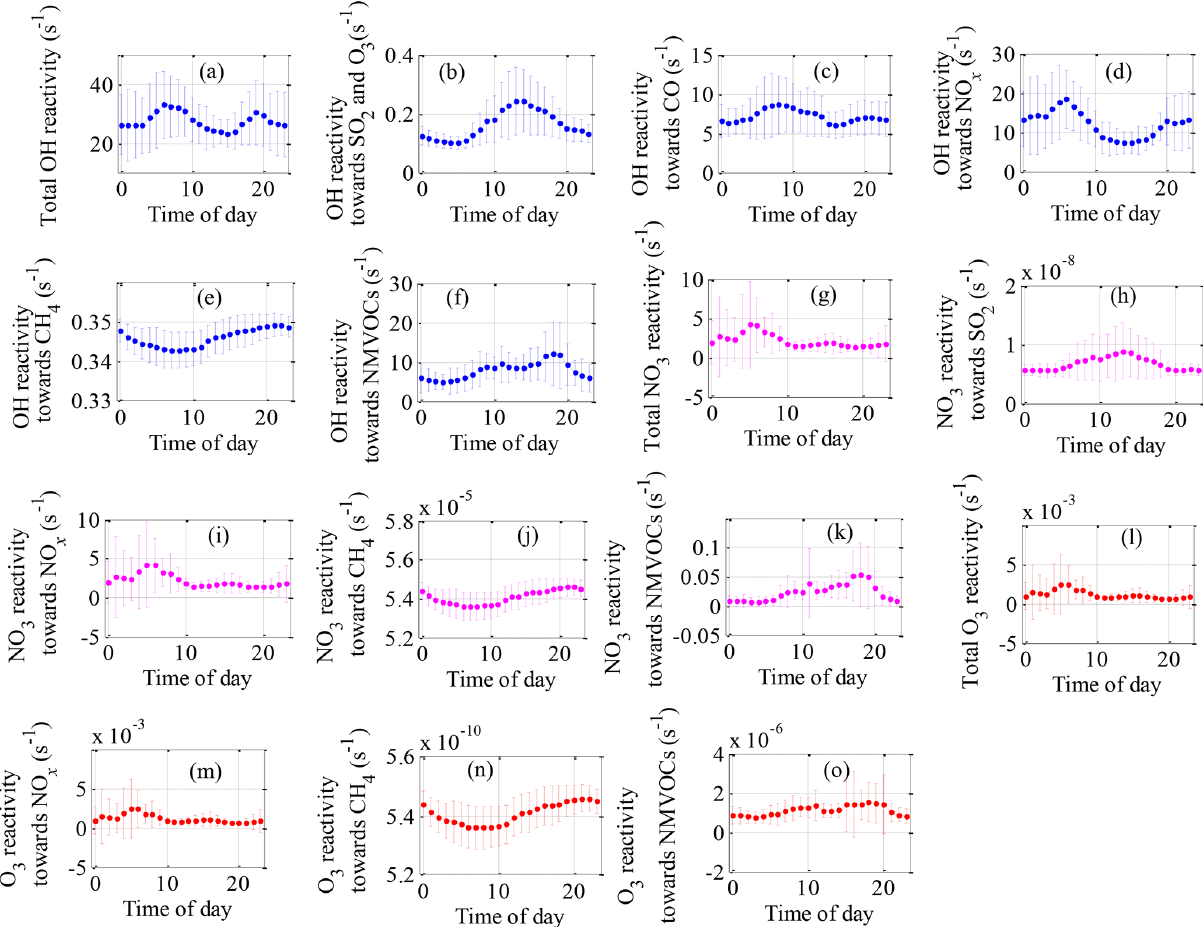
Figure 5. Mean diurnal variations in (a–f) OH reactivity, (g–k) NO 3 reactivity and (l–o) O 3 reactivity of trace gases during the field campaign at Xianghe from 6 July to 6 August